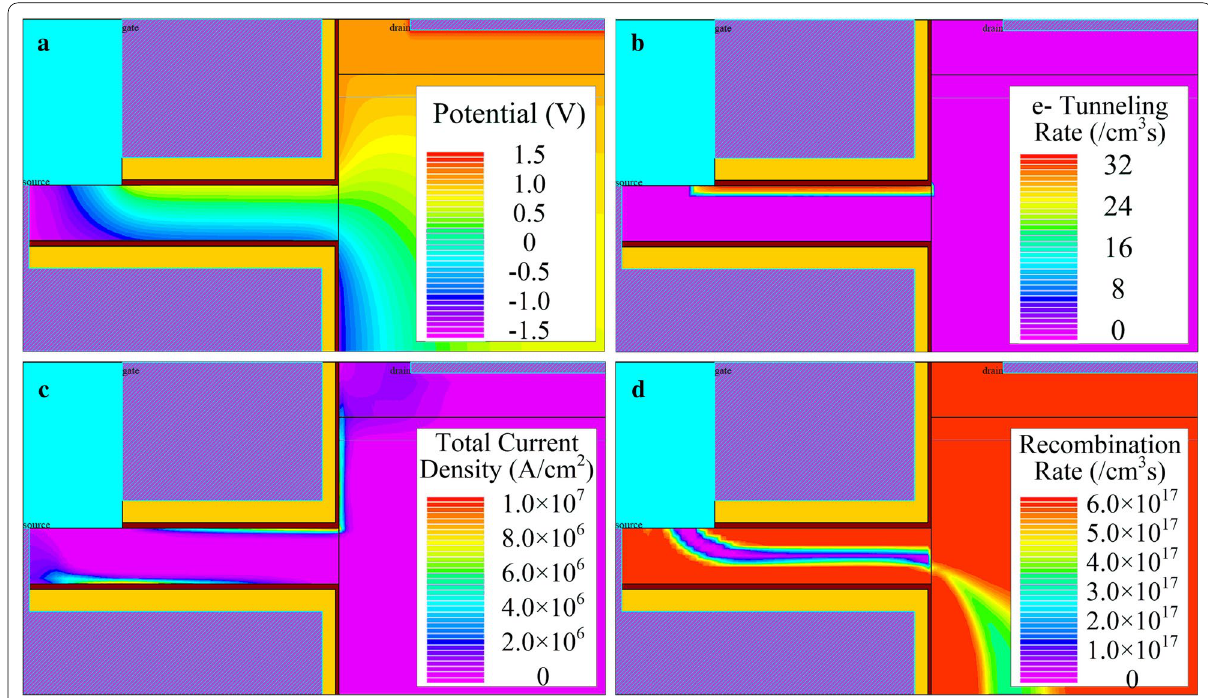
Fig. 4 Distribution of a potential, b e tunneling rate, c current density and d recombination rate of